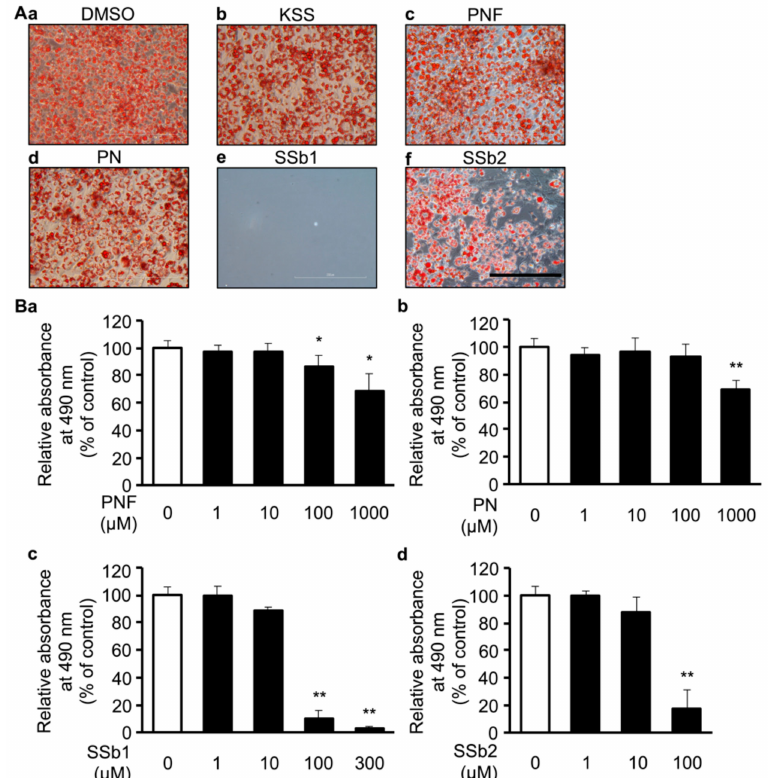
Figure 4. Paeoniflorin (PNF), Paeonol (PN), Saikosaponin B1 (SSb1), and Saikosaponin B2 (SSb2) reduce lipid accumulation in a dose-dependent manner. ( A ) ( Aa ) DMSO (DMI method only), ( Ab ) KSS 2 mg / mL, ( Ac ) PNF 1000 µ M, ( Ad ) PN 1000 µ M, ( Ae ) SSb1 300 µ M, or ( Af ) SSb2 100 µ M was added in culture media and cultured for 8 days. Images of Oil-Red-O staining are shown. The scale bar indicates 200 µ m. ( B ) PNF, PN, SSb1, and SSb2 were administered during di ff erentiation induction by the DMI method and cells were cultured for 8 days. As in Figure 1, the amount of lipid accumulation was measured and is shown as relative absorbance. ( Ba ) PNF, ( Bb ) PN, ( Bc ) SSb1, and ( Bd ) SSb2. Data are shown as mean ± standard deviation ( n = 3). * p < 0.05 and ** p < 0.01 vs.